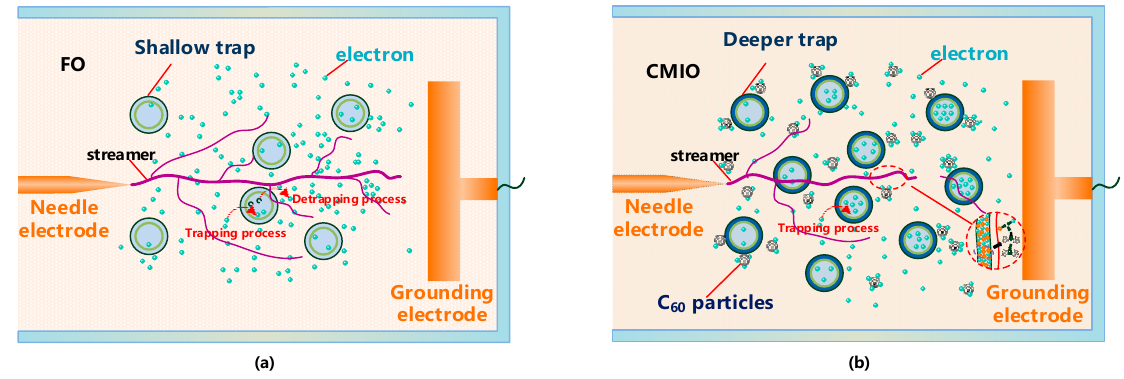
Figure 19. ( a ) Electron motion in FO under electric field, ( b ) Electron motion in CMIO under electric field.